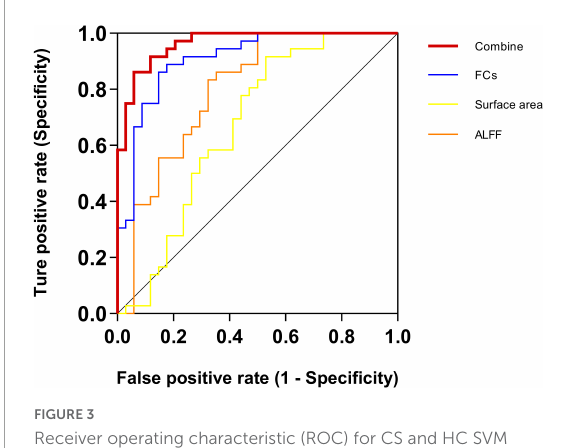
FIGURE3 Receiver operating characteristic (ROC) for CS and HC SVM classification analyses. For single-measurement analyses, the functional connectivity (FC) exhibited a higher AUC of 90.85% than the other two measurements. The surface area achieved the lowest AUC of 66.99%. Critically, the AUC improved after combining all features of the three measurements, achieving an AUC up to 96.41%. ALFF, the amplitude of low-frequency fluctuation; FC, functional